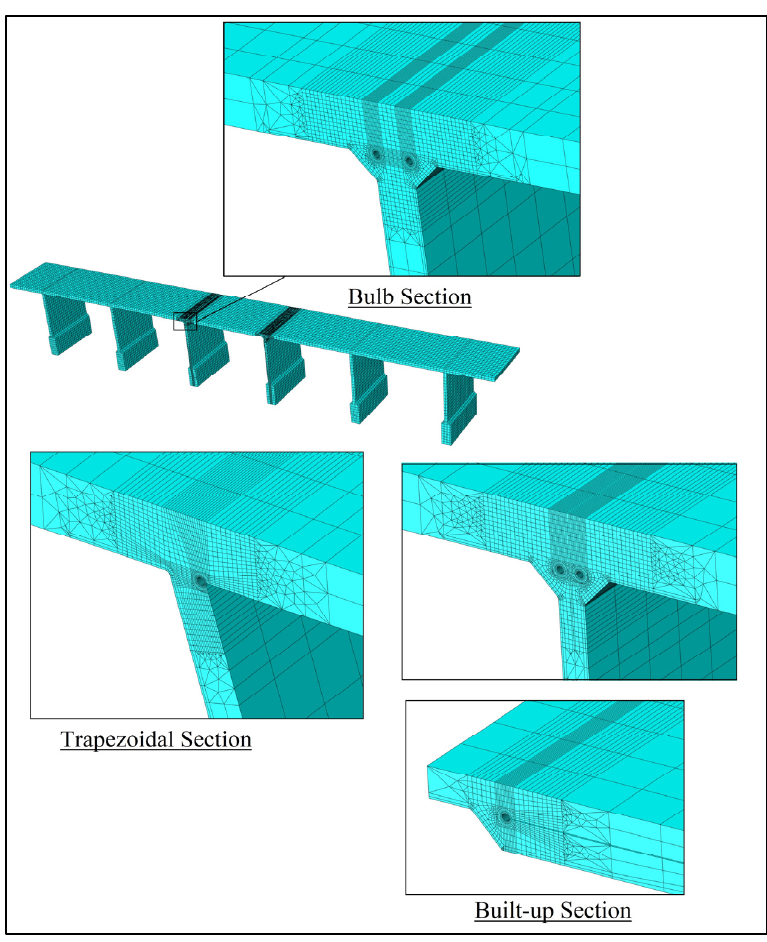
Figure 12. Partial three-dimensional continuum mesh of simulated decks.